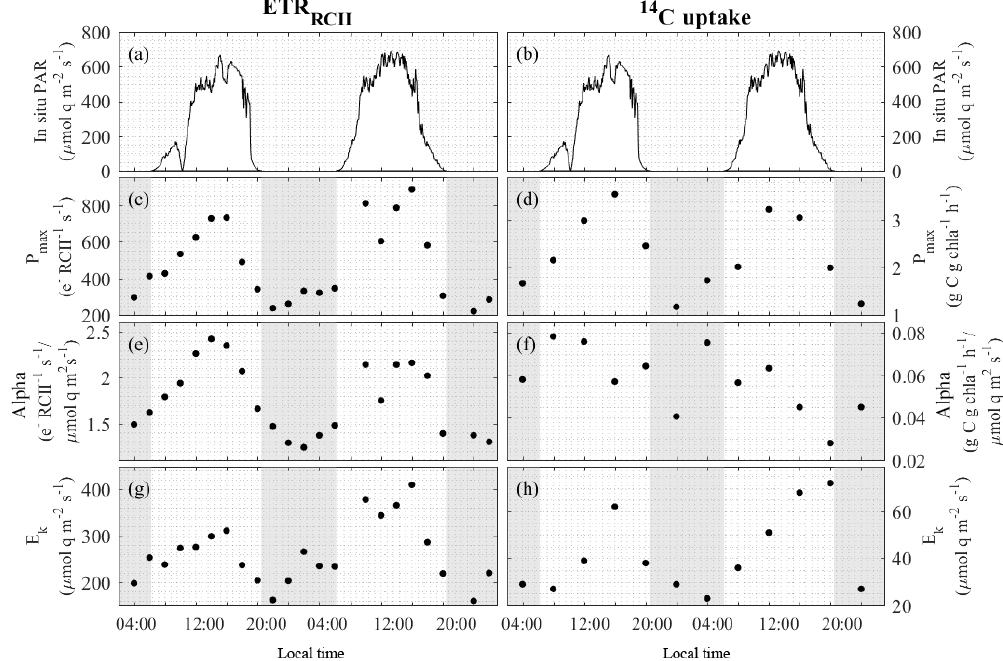
Figure 4. Diurnal variability in light-response curve fit parameters for ETR RCII (left) and 14 C uptake (right) for the OCE17 site. (a) and (b) show PAR at 5m sampling depths. (c) and (d) show the maximum light-saturated capacity P max of each rate. (e) and (f) show the light efficiency of each rate under light limitation, α . (g) and (h) show the light saturation parameter E k of each rate. Note different scales on (a) , (b) , (g) and (h) . Table 4. Comparison of environmental conditions at the offshore, iron-limited site OSP14 (17 June 2014) and the coastal, nutrient-rich site OCE17 (21 August 2017). See text for details on derivation of each